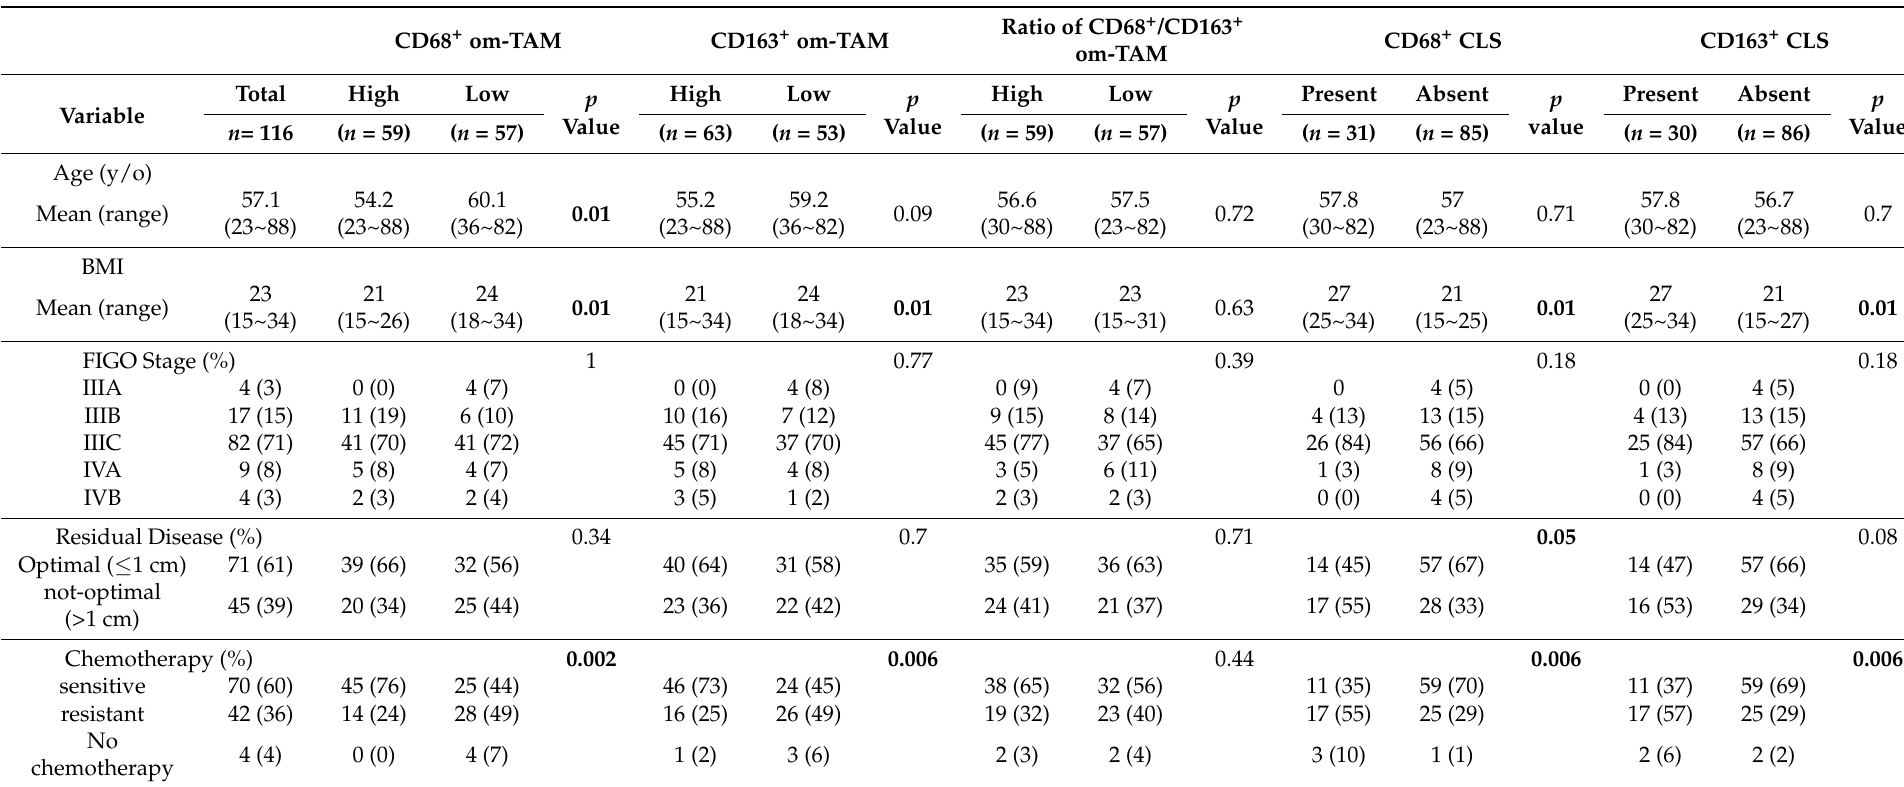
Table 1. Association between clinical parameters and omental TAM and CLS in 116 advanced stage serous ovarian cancer